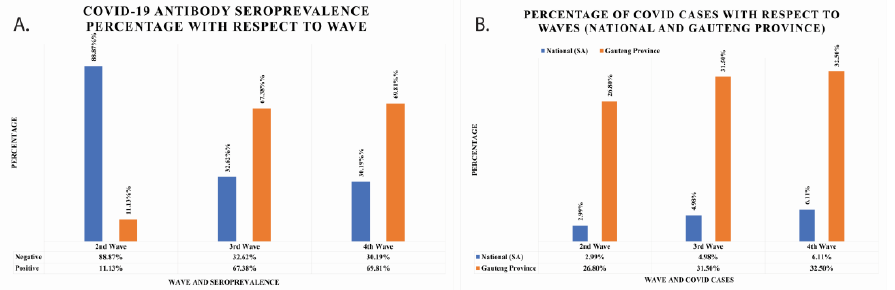
Figure 2. ( A ) The COVID-19 IgG/IgM seroprevalence percentage of cancer patients per wave represented with grey colours. The positive seroprevalence of COVID-19 IgG/IgM antibodies rises with waves. ( B ) The total number of COVID-19 cumulative cases per waves reported nationally and in Gauteng Province.